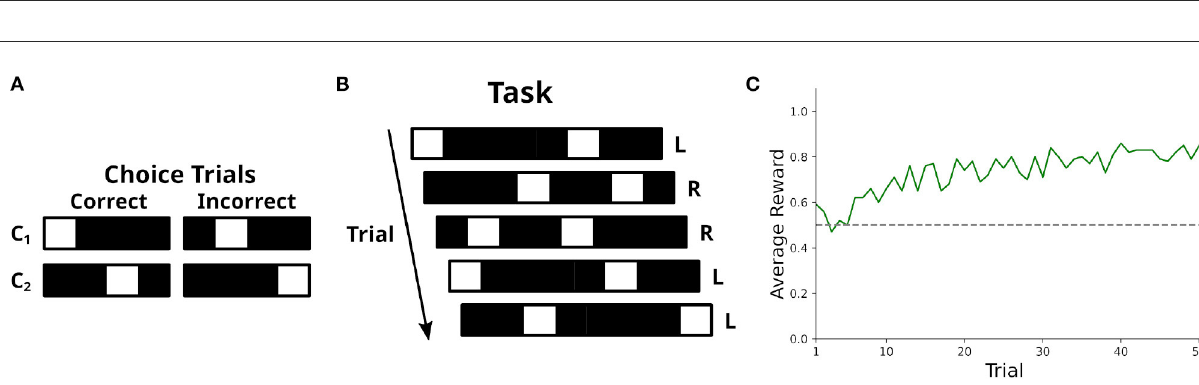
FIGURE9 Modeling of non-spatial tasks using CoBeL-RL. (A) Definition of the possible choice trials. Each choice trial consists of two stimuli: the correct one, which is rewarded, and the incorrect one, which is not rewarded. (B) Illustration of the decision task. In each trial, a random choice trial is presented and the positions of the stimuli are randomized. The correct choice for the trial is indicated as left (capital L) or right (capital R). (C) Learning performance of a DQN agent in the task measured via the average reward received. Performance is at chance level (indicated by the dashed horizontal gray line) in the beginning but quickly improves within the first couple of